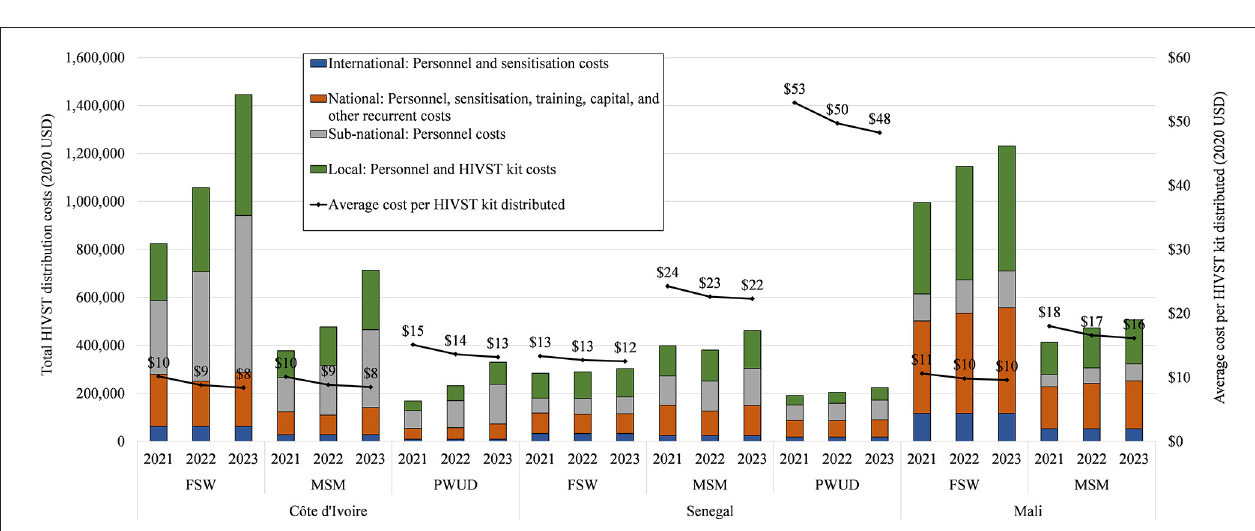
and key groups, in transition and scale-up, overall cost drivers are fixed costs such as sensitisation activities, and headquarter- based personnel costs at national and sub-national level, and variable costs such as training and HIVST kits costs (varying with HIVST distribution targets). In Senegal, we estimate higher personnel costs at CSO level (headquarter- and field-